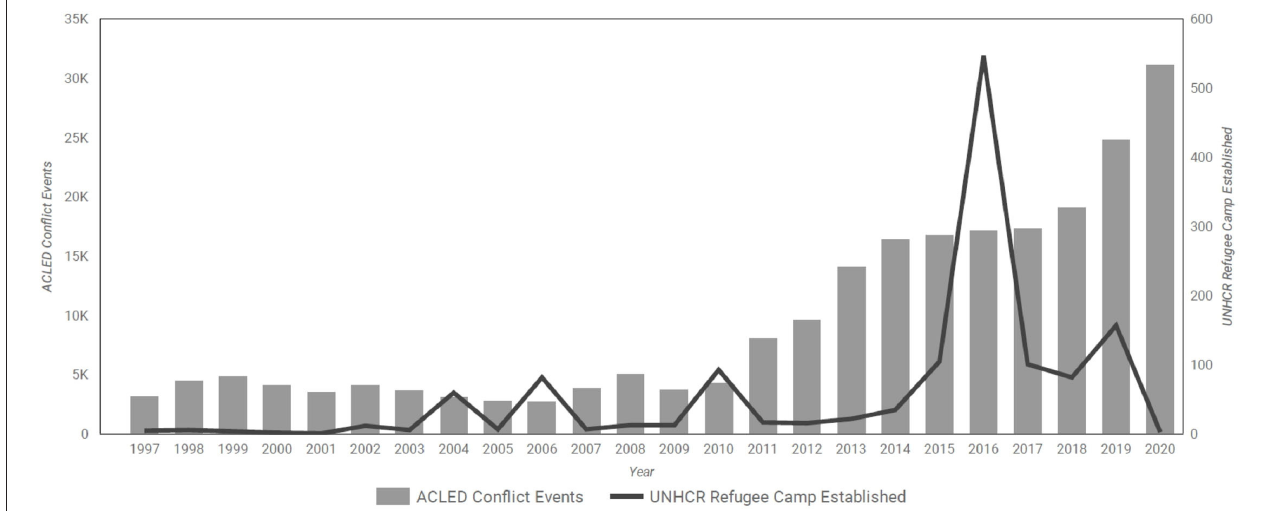
FIGURE 2 | Number of ACLED conflict events in Africa per year from 1997 to 2020, overlaid with the number of UNHCR refugee camps established per